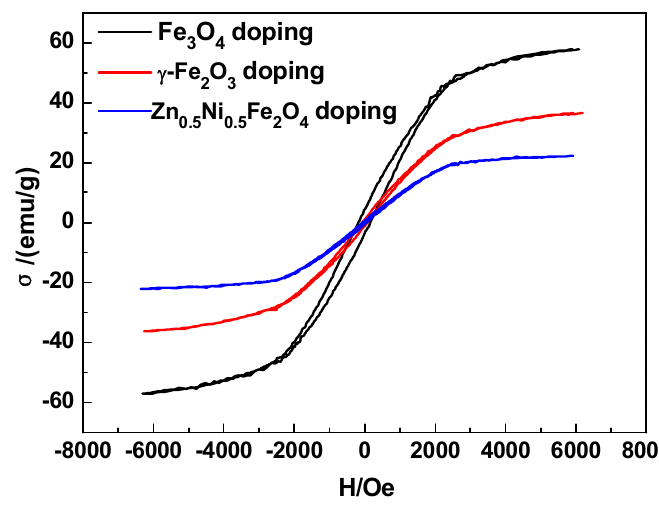
Figure 7. Magnetization curves of Fe series magnetic nanoparticle/C hybrid CMS membranes (content of doping Fe 3 O 4, γ -Fe 2 O 3 or Zn 0.5 Ni 0.5 Fe 2 O 4 is 15 wt%) [65].